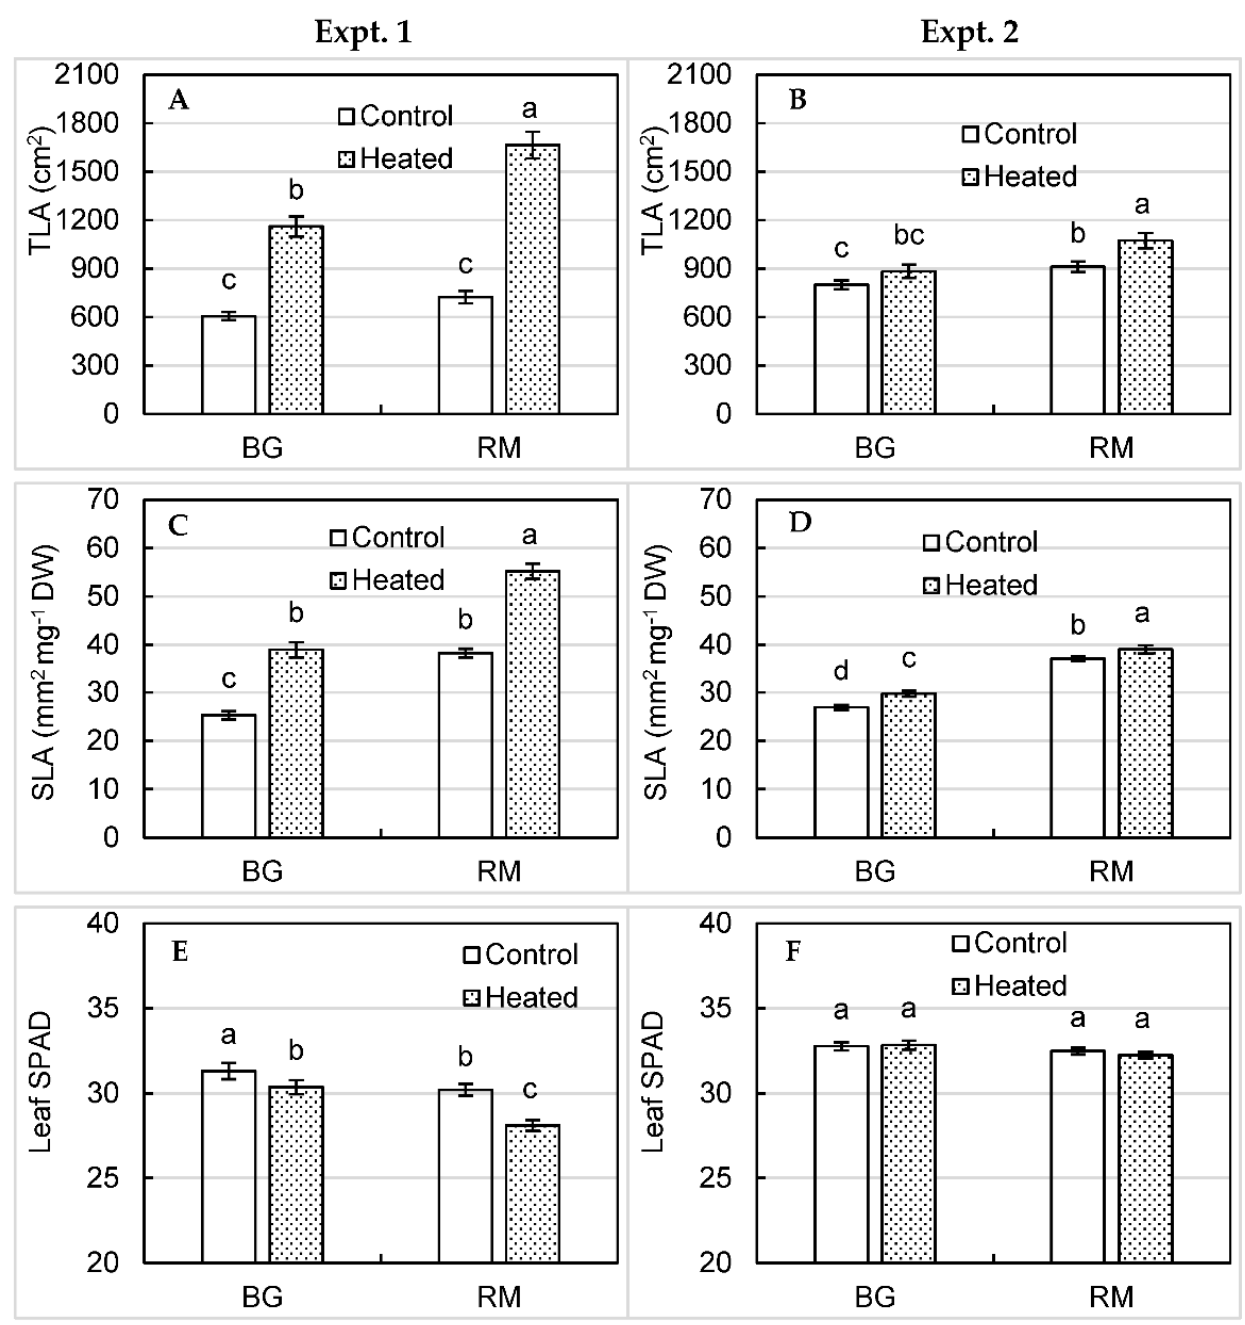
Figure 5. Total leaf area (TLA) ( A , B ), specific leaf area (SLA) ( C , D ), and leaf relative chlorophyll content (SPAD) ( E , F ) of the lettuce varieties ‘Bergam’s Green’(BG) and ‘Red Mist’ (RM) grown in a deep-water culture hydroponic system with nutrient solution heating or no heating (control). Different letters represent significant differences between treatments according to Tukey’s HSD test ( p < 0.05). Leaf SPAD was affected by the heated treatment in Expt. 1, but not Expt. 2 (Figure 5E,F). In Expt. 1, the heated treatment relative to control reduced leaf SPAD by 3% and 7% in ‘Bergam’s Green’ and ‘Red Mist’,